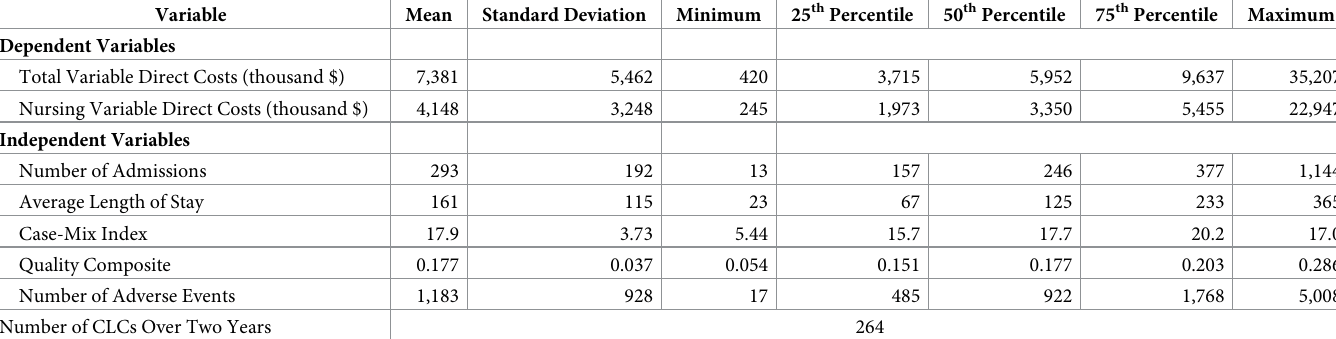
Table 2. Dependent and independent variable descriptive statistics: CLCs for